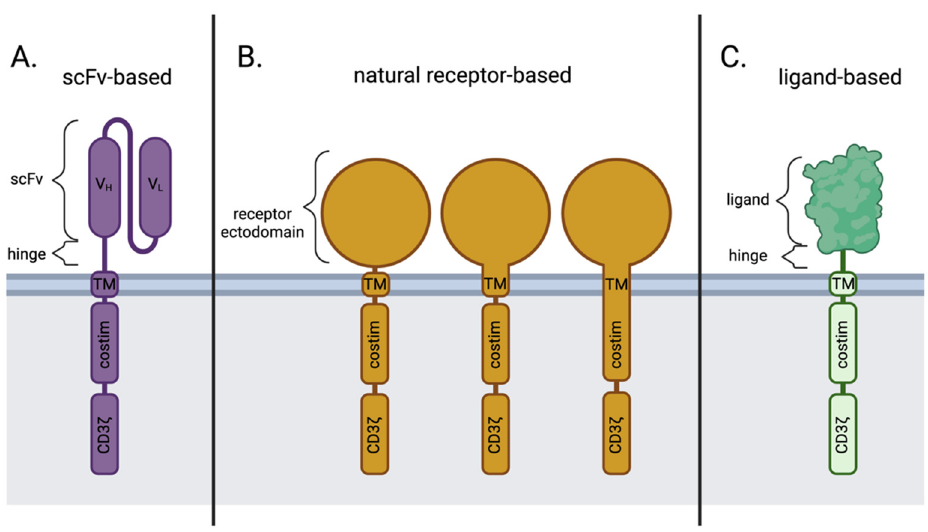
Figure 2. Key differences in antigen-binding domains between scFv-based, natural receptor-based, and ligand-based CAR designs. ( A ) scFv-based CARs; ( B ) natural receptor-based CARs may contain the transmembrane and/or costimulatory domains from the natural receptor itself or other sources, like CD28 or 4-1BB; ( C ) ligand-based CARs. Costim; Costimulation. scFv; single-chain variable fragment. TM; transmembrane. V H ; Variable heavy chain. V L ; Variable light chain. Created with BioRender.com.